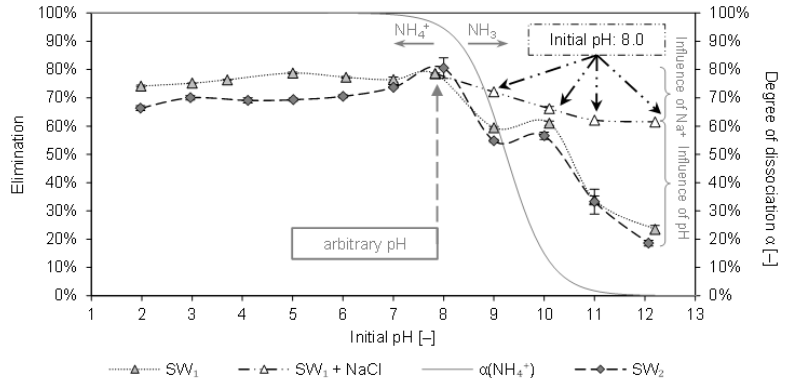
Figure 2. Elimination of ammonium from sludge water by CCP 20 (SW1: c 0 = 967 mg/L NH 4 -N; SW2: c 0 = 927 mg/L NH 4 -N; T = 295 K; sorbent ration 0.1 g CLI /mg NH4-N ) after 20 h contact time as a function of different initial pH of the sludge water (adjusted pH before contact with CCP 20); in addition, the influence of an equimolar amount of Na + (from NaCl instead of NaOH to raise the pH) on the elimination is shown; degree of dissociation of ammonium in grey.